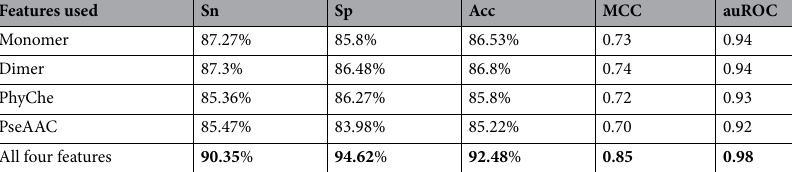
Table 7. Performance comparison when each individual feature is used independently. Experiments have been performed on the benchmark dataset containing 880 samples in each class. Bold denotes our proposed tool results.